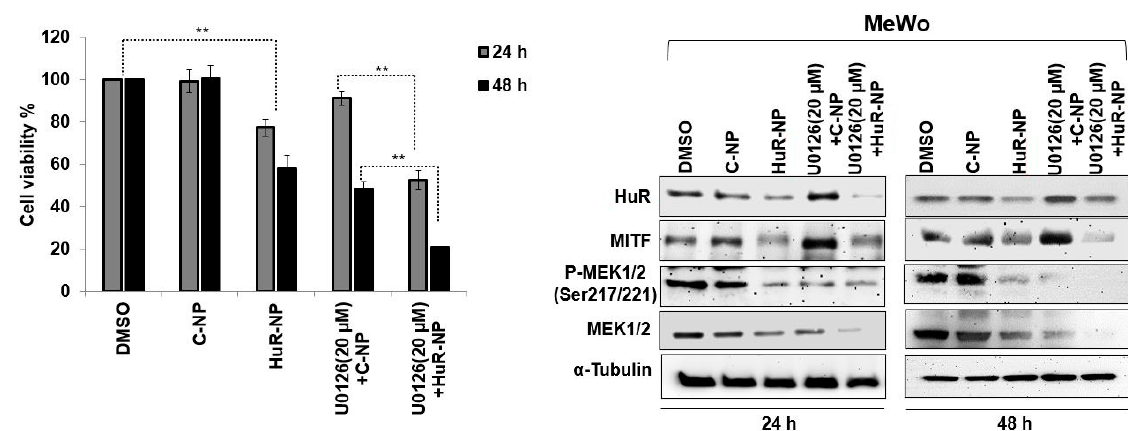
Figure 7. Cytotoxic effect of HuR-NP and U0126 combinatorial therapy in melanoma cell lines. Cells were treated with C-NP, HuR-NP, U0126, and a combination of C-NP or HuR-NP with U0126, and cell viability was assessed at 24 h and 48 h after treatment. DMSO-treated cells served as a control. HuR-NP plus U0126 treatment produced the greatest antitumor activity compared to all other treatment groups. Western blotting showed that HuR-NP plus U0126 combination treatment significantly reduced MITF, p-MEK1/2 Ser217/221 , and total MEK1/2 compared to all other treatment groups. Error bar denotes SD; ** p < 0.01.